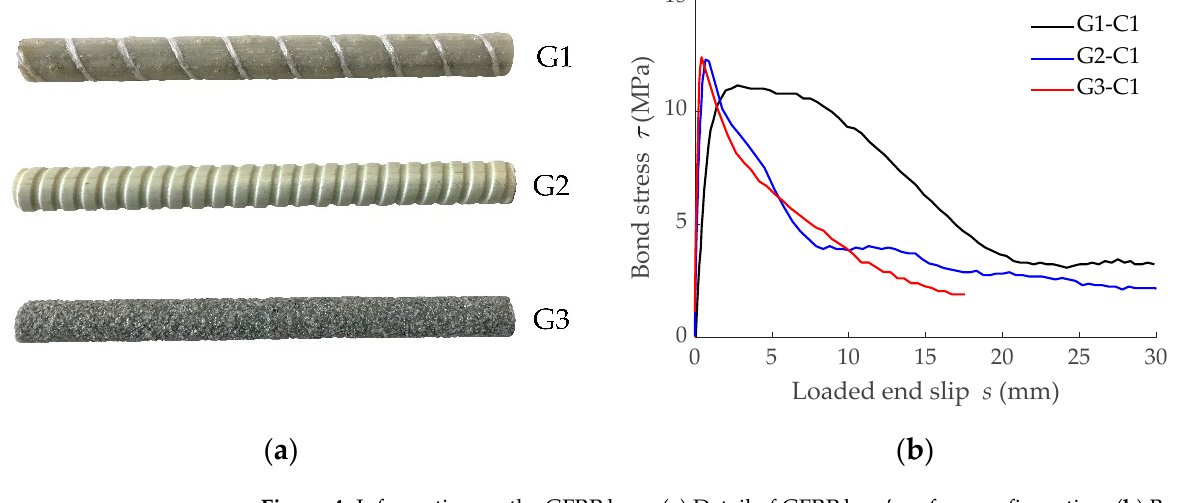
Figure 4. Information on the GFRP bars: ( a ) Detail of GFRP bars’ surface configuration; ( b ) Bond-slip laws between the GFRP bars and low concrete grade (C1) [8].